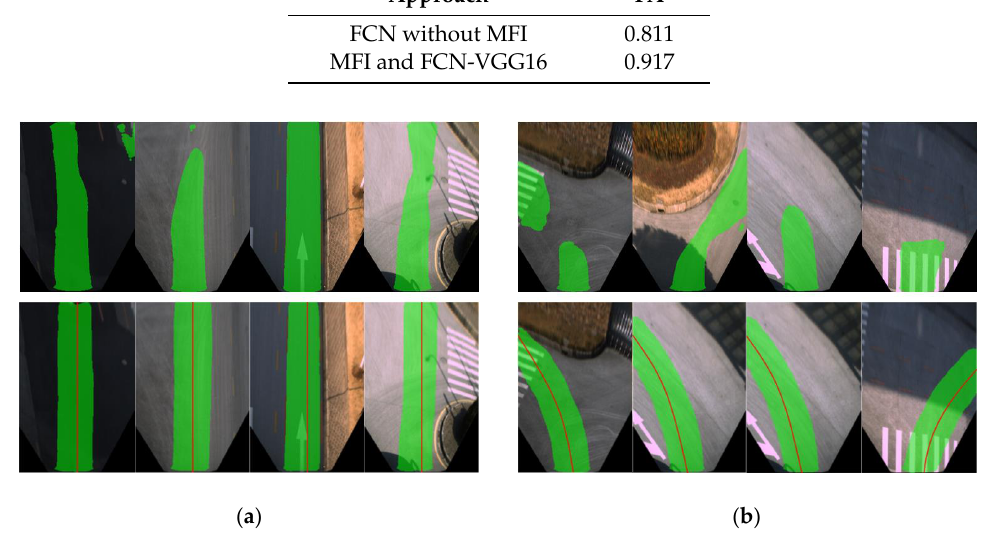
Figure 8. Comparison of detection results. The upper row shows the results of conventional FCN without MFI, and the lower row is the detection results of the proposed approach. ( a ) Detection results of straight road segments; ( b ) Detection results of intersections and turning segments .